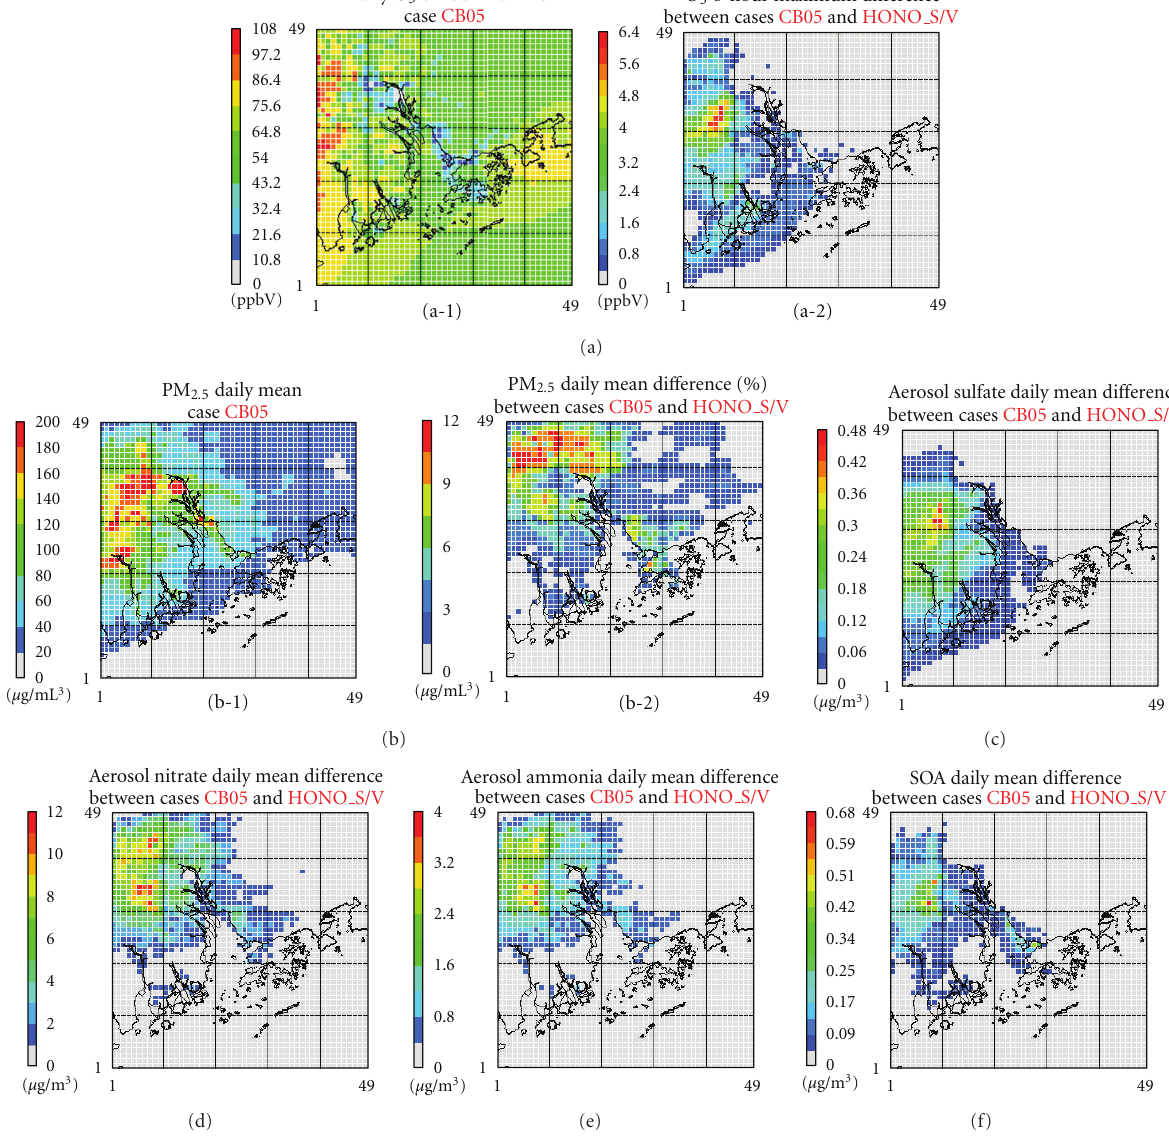
Figure 9: Spatial distribution of the maximum enhancement due to the HONO chemistry during the entire simulation period for (a) ∗ daily 8-hour maximum ozone, (b) ∗ daily mean PM 2 . 5 , (c) daily mean aerosol sulfate, (d) daily mean aerosol nitrate, (e) daily mean aerosol ammonia, and (f) daily mean SOA. ∗ (a-1) and (b-1) are the spatial distribution of base case simulation CB05, while (a-2) and (b-2) are the spatial distribution of di ff erence between simulation cases HONO S/V and CB05 (see Table